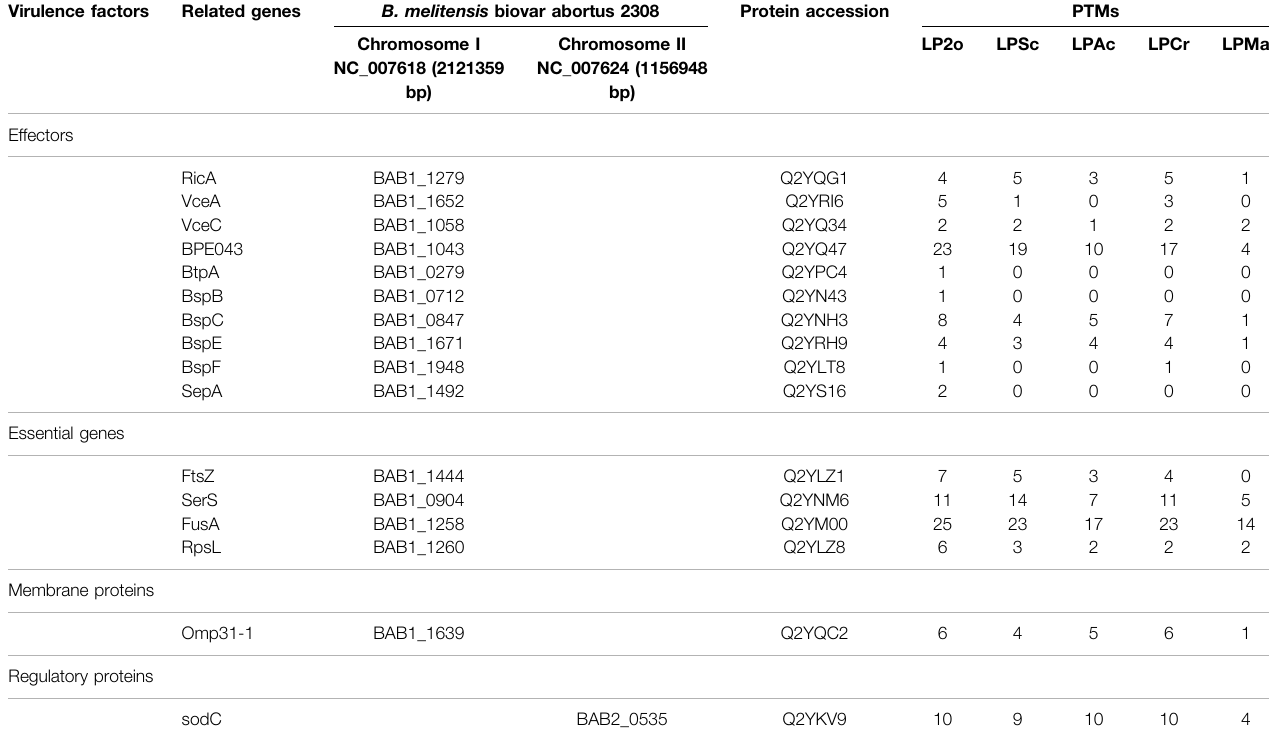
TABLE 2 | Modi fi cation of effectors, essential genes and regulatory proteins in Brucella